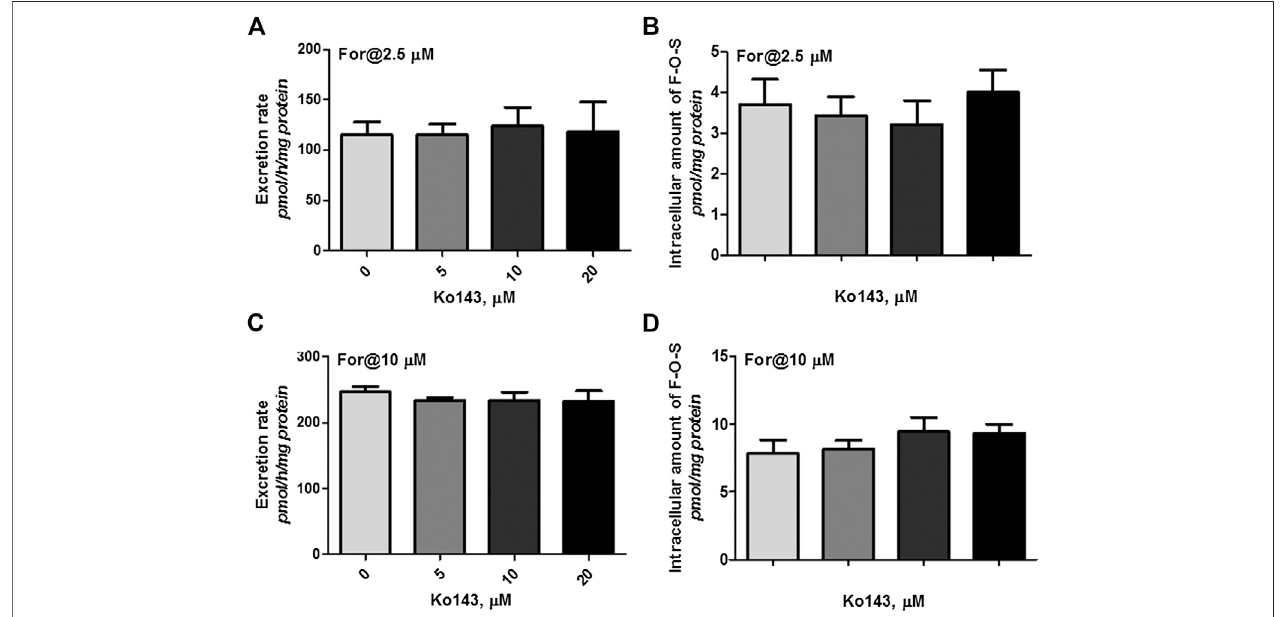
FIGURE 7 | Effects of Ko143 (5 – 20 μ M) on formononetin (2.5 and 10 μ M) disposition in HEK-SULT1A3 cells. Effects of Ko143 on the excretion rates (A) and intracellular amounts (B) of formononetin sulfate at a low loading concentration of formononetin (2.5 μ M). Effects of Ko143 on the excretion rates (C) and intracellular amounts (D) of formononetin sulfate at a high loading concentration of formononetin (10 μ M). Each data point was shown as mean ± SD (n (cid:1) 3).